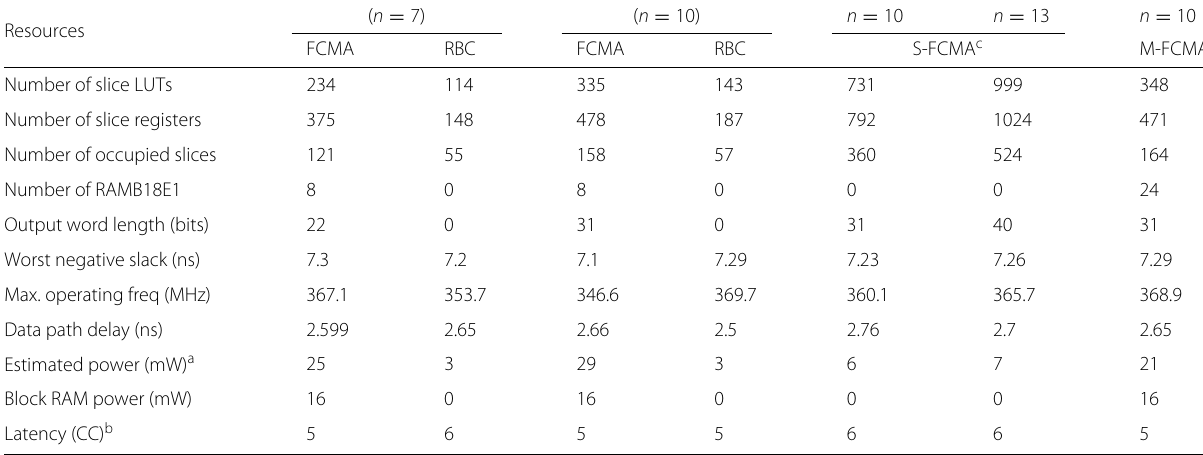
Table 4 FPGA resource utilization and system performance for the RNS components— i.e., FCMA and reverse converter Resources